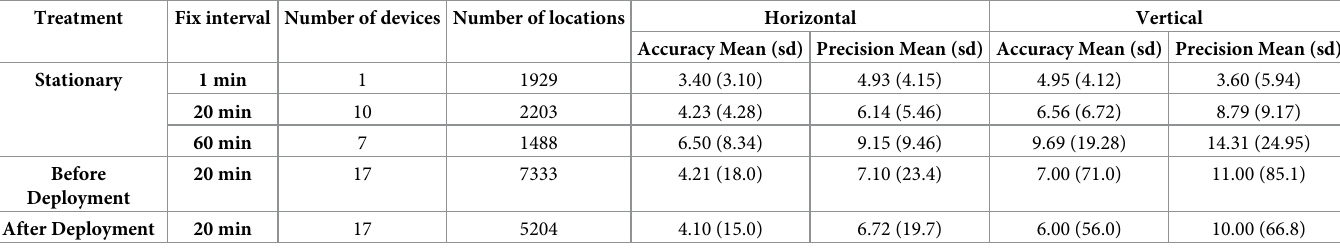
Mean and standard deviation of horizontal and vertical accuracy and precision, in meters, in the different fix